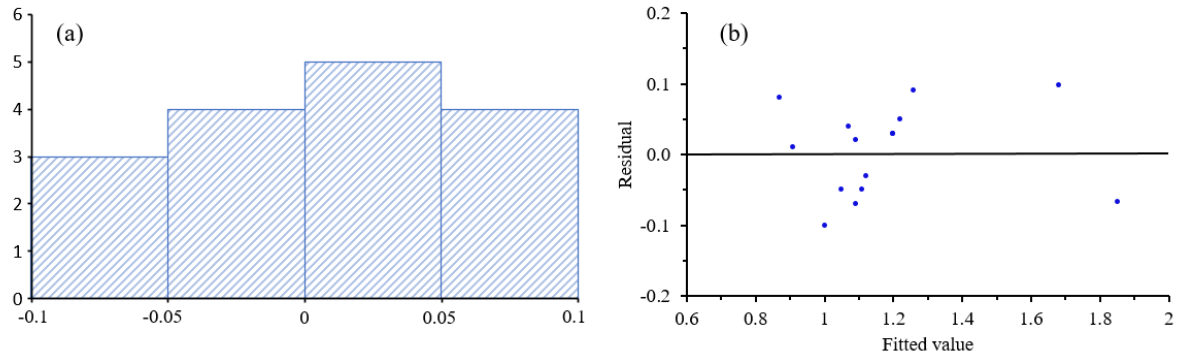
Figure 12. Residual plots of the multiple parameter model ( a ) residual histogram plot, ( b ) normal residual of the fitted curve (calculated value subtracted by measured value).